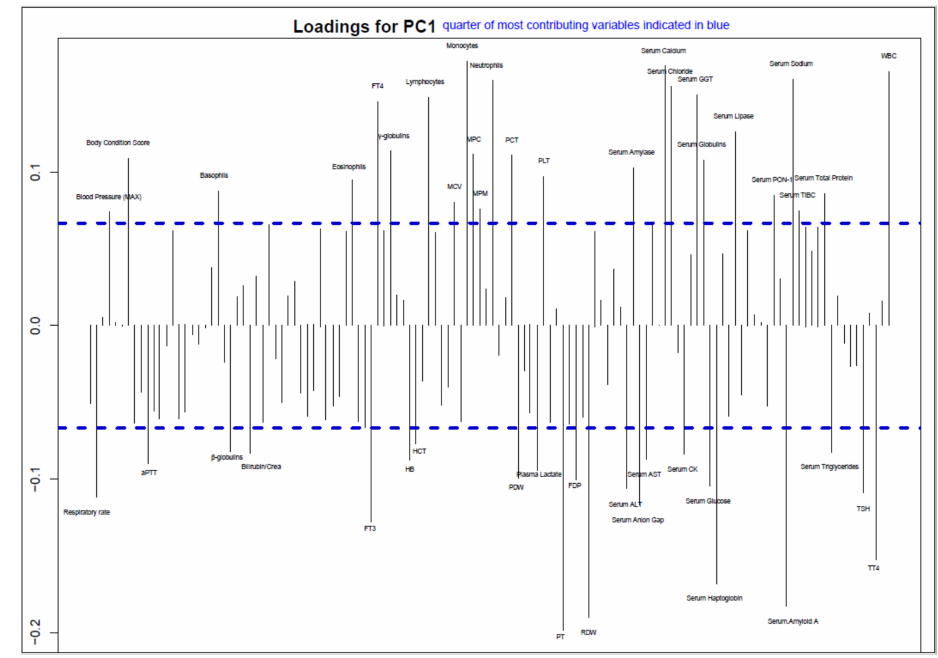
Figure 4. Loadings of the first global component. Only labels of variables selected for association analysis with Abouheif’s test (i.e., variables with loadings in the higher 75 percentile represented by blue dashed lines) are